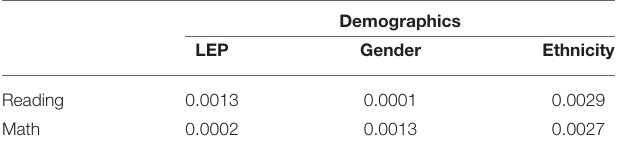
TABLE 6 | The R 2 associated with predicting the slope found from the conditional modes for the MAP administrations for reading and math by demographics variables, treated as categories. As these are all small it shows that the rate of change of these scores does not differ greatly across these demographics. Demographics LEP Gender